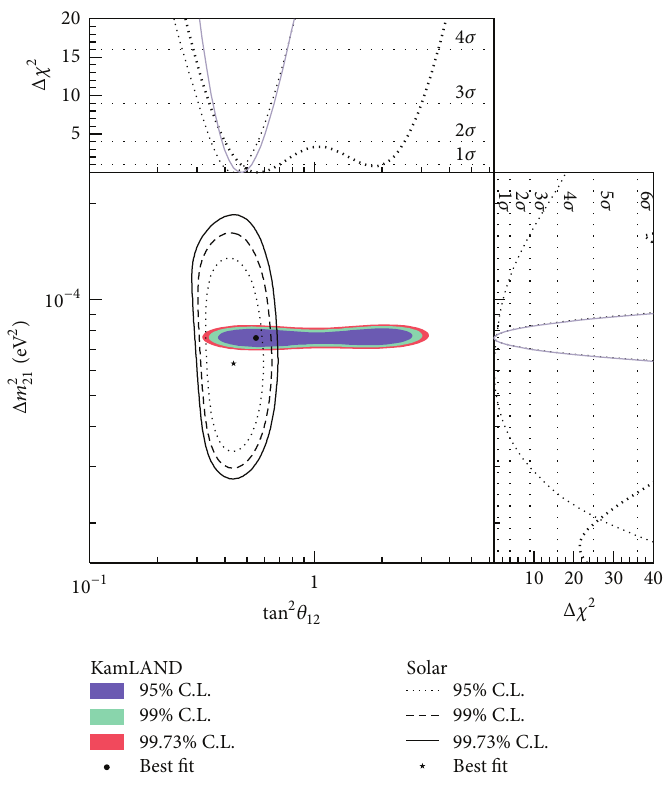
Figure 5: Allowed region for neutrino oscillation parameters from KamLAND and solar neutrino experiments. The side-panels show the Δ𝜒 2 -profiles for KamLAND (dashed) and solar experiments (dotted) individually, as well as the combination of the two (solid). Taken from